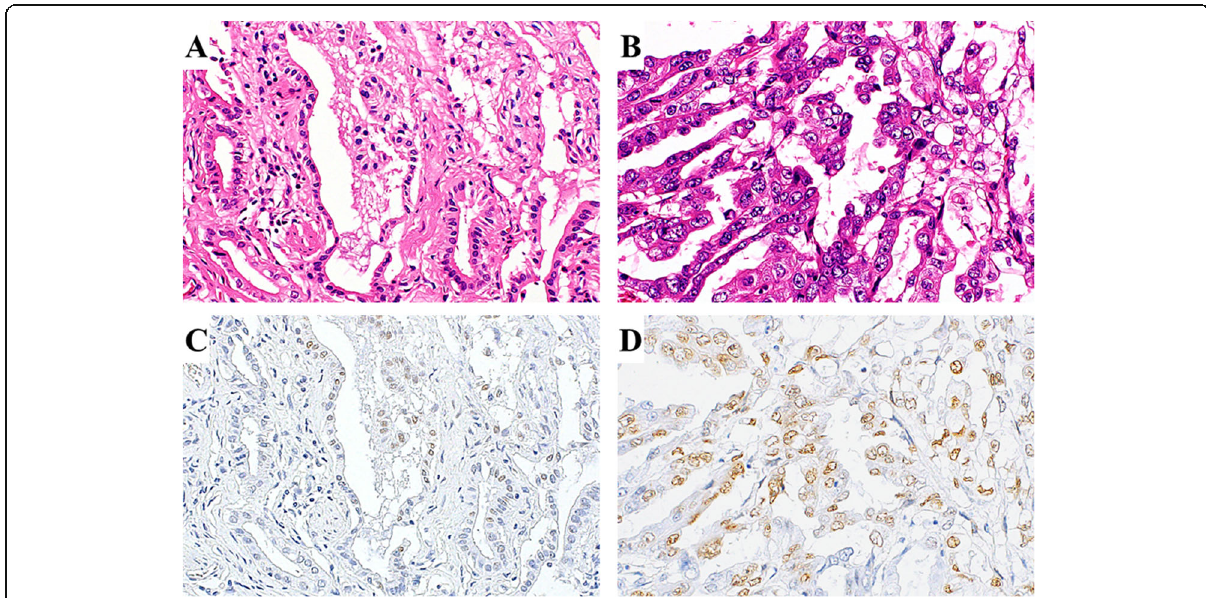
Fig. 2 γ -H2AX expression in cancerous and non-cancerous areas of gallbladder tissue in patients with pancreatobiliary maljunction (PBM). Representative hematoxylin and eosin-stained images of the ( A ) non-cancerous area and ( B ) cancerous area. Immunohistochemical staining of γ - H2AX in the ( C ) non-cancerous area and ( D ) cancerous area. The cancerous area appeared to have stronger and more diffuse staining than the adjacent non-cancerous area. γ -H2AX, phosphorylated H2AX at Ser139 (200x